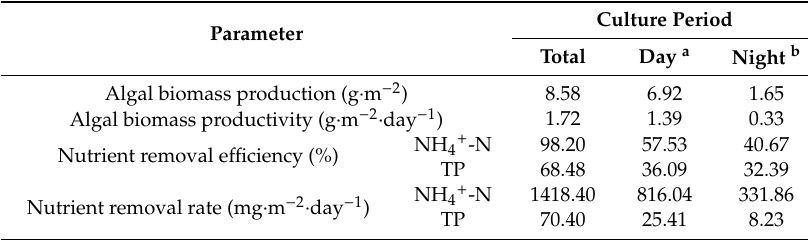
Table 2. Pig urine treatment results in batch mode. Parameter